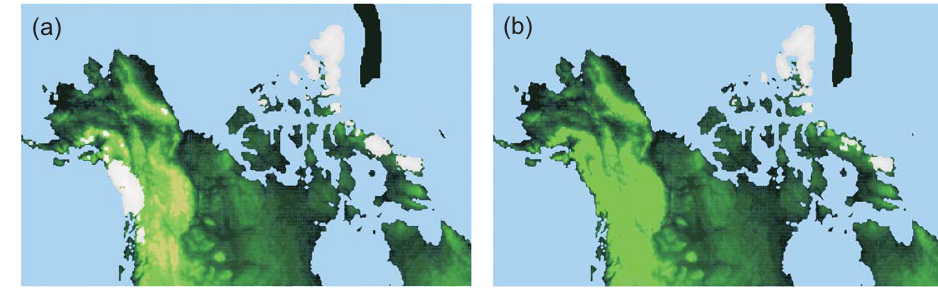
Fig. 5. Ice sheet configurations for the (a) pre-industrial control and (b) “low-45N” mountains simulations (see text for